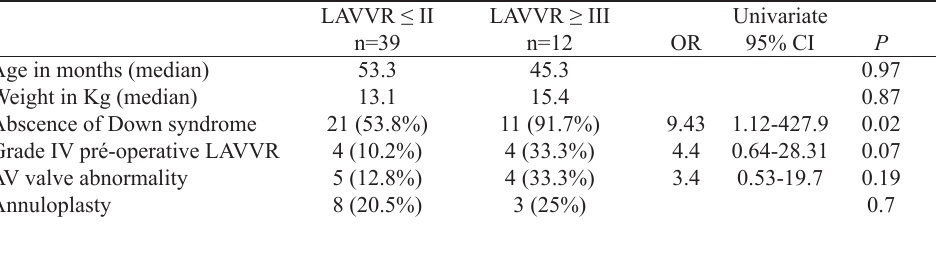
Table 3. Univariate relations between variables and moderate or severe postoperative left atrioventricular valve regurgitation (LAVVR).